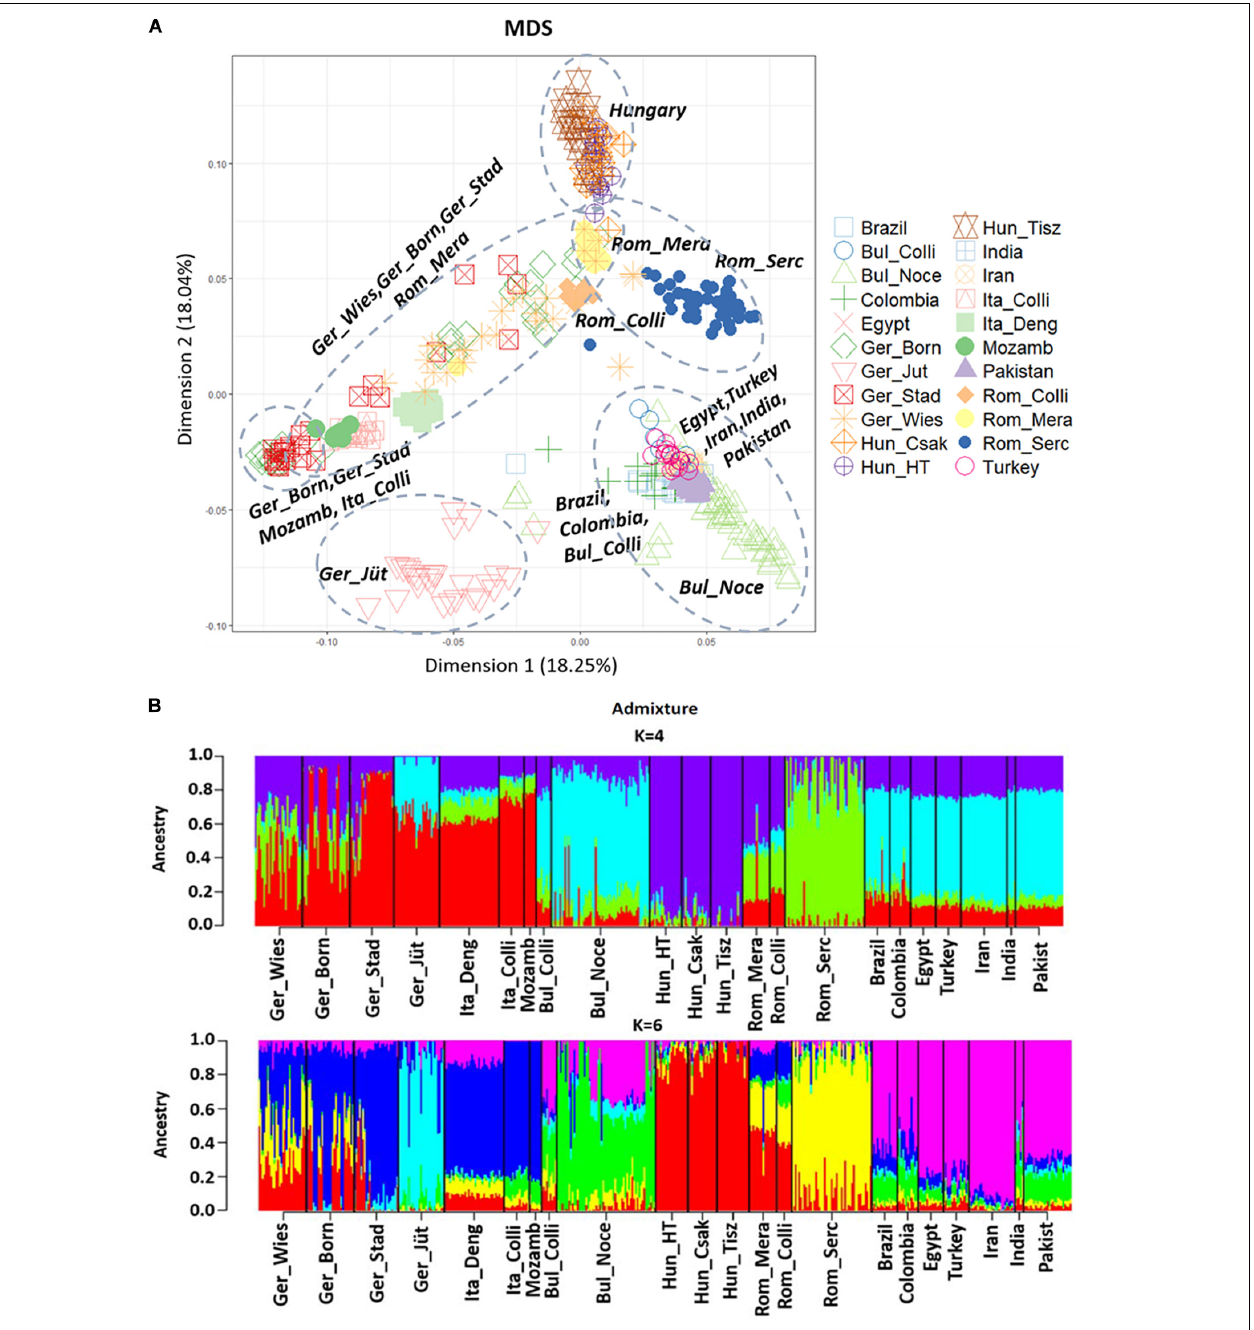
FIGURE 3 | (A) Multi-Dimensional Scaling (MDS) plot based on genome-wide identity-by-state pairwise inferred with PLINK V1.7, including 36.014 SNPs from 477 individuals. This plot shows the genetic distance between all the 22 populations analyzed worldwide and published in part (Colli et al., 2018a; Deng et al., 2019a). The percentage of variances captured for each dimension is reported in brackets. The dashed circles mark the populations that cluster together. (B) Admixture analysis results at K = 4 and 6, including 22 buffalo populations worldwide. K values indicate the number of ancestries estimation (clusters), K = 6 was the best fitting solution for the lowest cross-validation error reported (CV = 0.61856). Populations are divided by a vertical black line, and it is partitioned into K colored segments that represent the population’s estimated membership fractions in K clusters. The 22 populations are localized in Germany (Ger_Wies, Wiesenburg, n = 28: Ger_Born, Born, n = 28; Ger_Stad, Stadland, n = 26; Ger_Jüt, Jüterbog, n = 27), Italy (Ita_Deng according to Deng et al., 2019a, n = 35; Ita_Colli according to Colli et al., 2018a, n = 15), Mozambique (Mozamb according to Colli et al., 2018a, n = 7), Bulgaria (Bul_Colli according to Colli et al., 2018a, n = 11), Bulgaria (Bul_Noce, n = 58), Hungary (Hun_HT, Földes, n = 19; Hun_Csak, Csákvar, n = 17; Hun_Tisz, Tiszataj, n = 19), Romania (Rom_Colli according to Colli et al., 2018a, n = 9; Rom_Mera, Mera, n = 16; Rom_Serc, Sercaia, n = 47), and also according to Colli et al., 2018a: Brazil ( n = 15), Colombia ( n = 12), Egypt ( n = 15), Turkey ( n = 15), Iran ( n = 27), India ( n = 5), and Pakistan ( n = 28). Population labels and the number of individuals of both analyses are reported in Tables 1 , 2 .